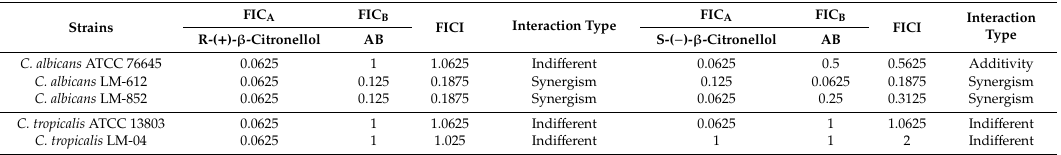
FIC A : fractionedinhibitoryconcentrationof“A”, represents(R-( + )- β -citronellol / S-( − )- β -citronellol); FIC B : fractioned inhibitory concentration of “B” represents the standard antifungal (AB). FICI: fractionated inhibitory concentration index, obtained by the sum of FIC A and FIC B , characterizes the type of interaction (synergism, additivity, indi ff erence, or antagonism). For S-( − )- β -citronellol with AB, three distinct e ff ects were seen: additivity for C. albicans ATCC-76645 (FICI: 0.5625), synergism for C. albicans LM-612 (FICI: 0.1875) and C. albicans LM-852 (FICI: 0.3125), and indi ff erence for the other strains of C. tropicalis: ATCC 13803 (FICI: 1.0625) and LM-04 (FICI: 2). When performing the statistical analysis about the FICI of the association between (R)-( + )- β -citronellol and (S)-( − )- β -citronellol associated with AB, to analyze which was most promising, no statistically significant di ff erences were observed between them against the strains of C. albicans ( p = 1) and C. tropicalis ( p =